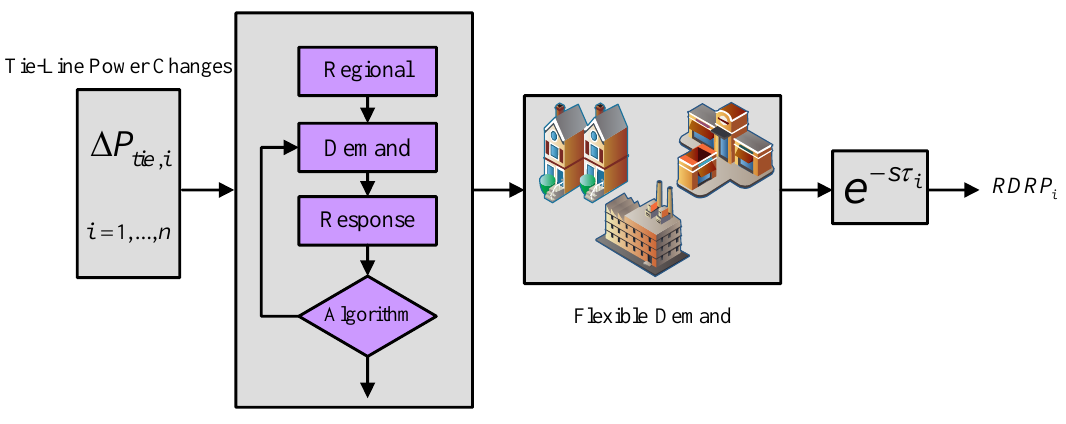
Figure 6. Modeling of the RDRPs.